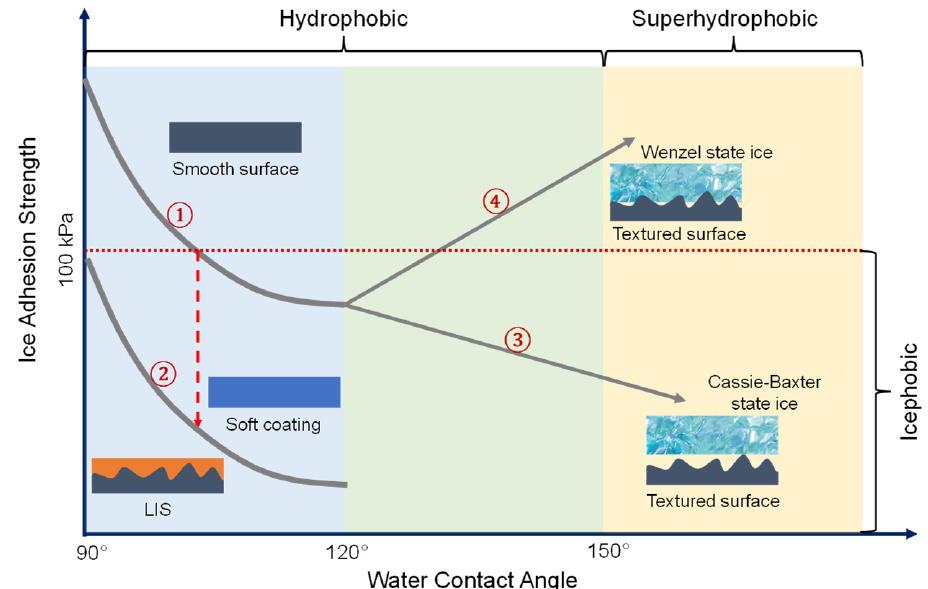
Figure 1. The schematic of hydrophobic and superhydrophobic coating design for anti-icing .